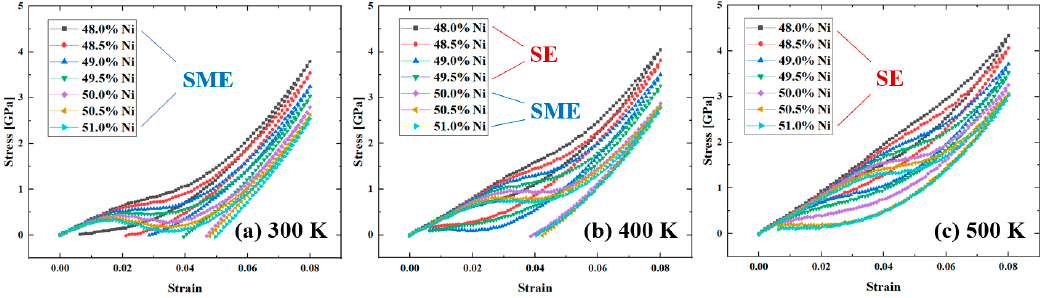
sion at the temperature of ( a ) 300 K, ( b ) 400 K and ( c ) 500